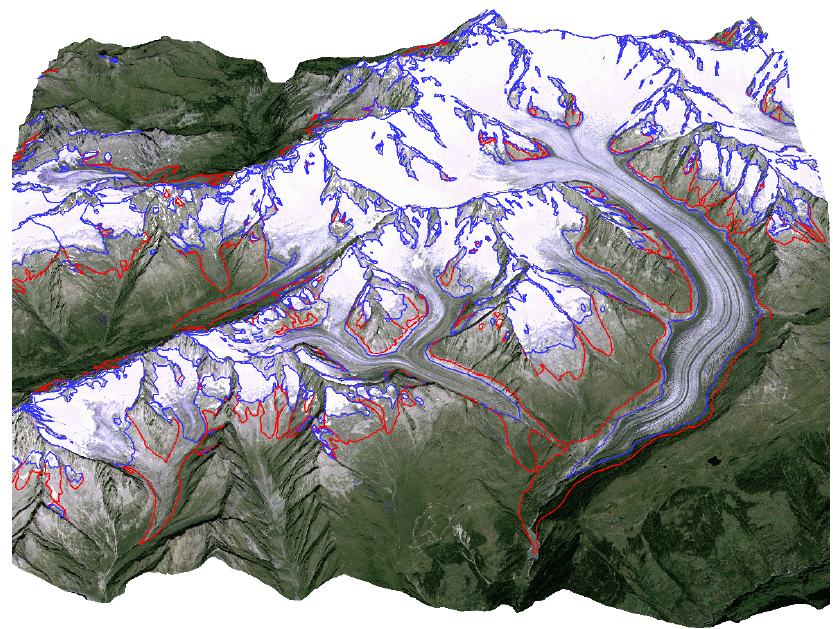
Figure 4. The region around Great Aletsch Glacier in a synthetic oblique perspective view created from a pan-sharpened satellite image (Landsat TM with IRS-1C) and glacier outlines from 1850 (red) and 1973 (blue) draped over a DEM. The region covered is 40 km by 41 km in size. DEM 25: Reproduced with permission by swisstopo